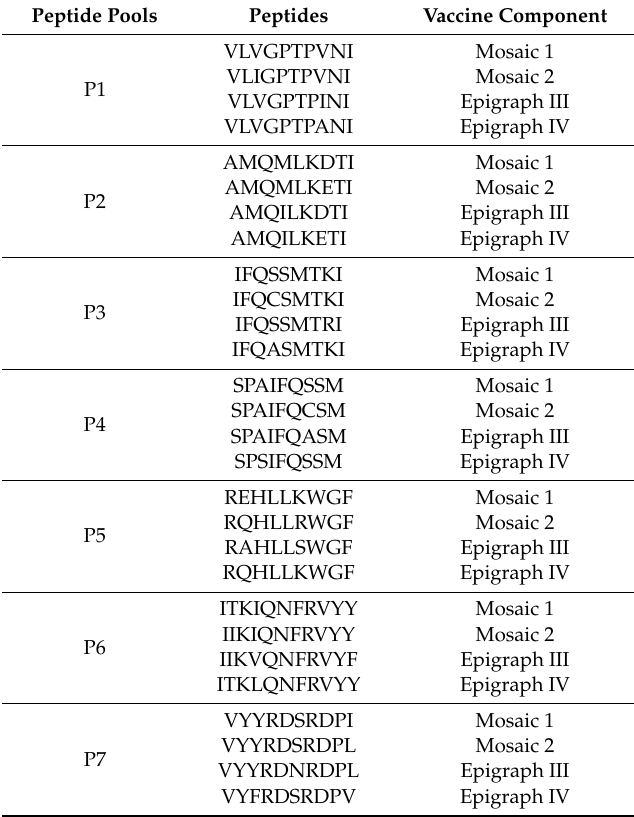
Table 1. H-2 d epitopes and their frequent variants used for response